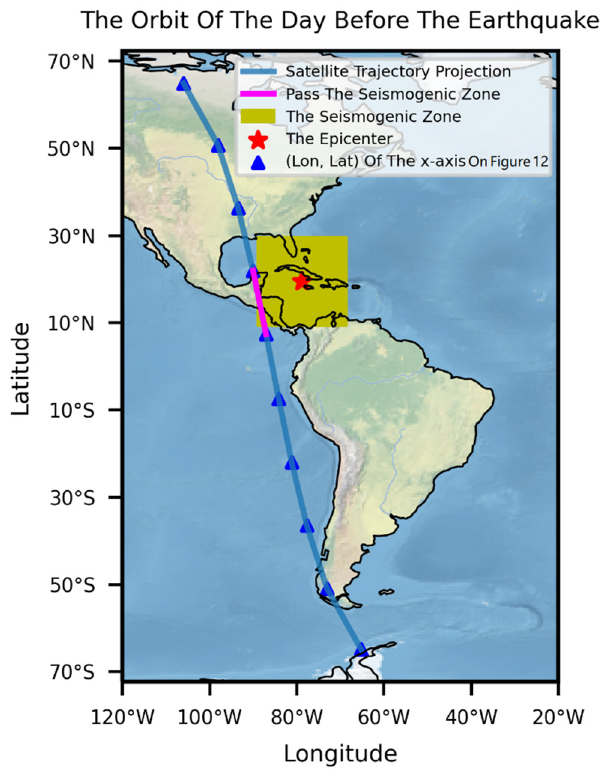
Figure 10. Satellite trajectory projection on 28 January 2020.